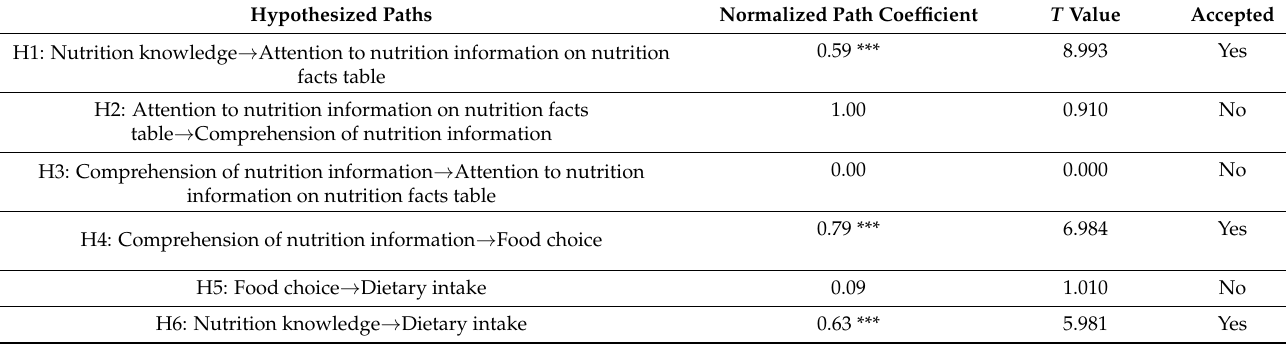
Table 7. Test results of the